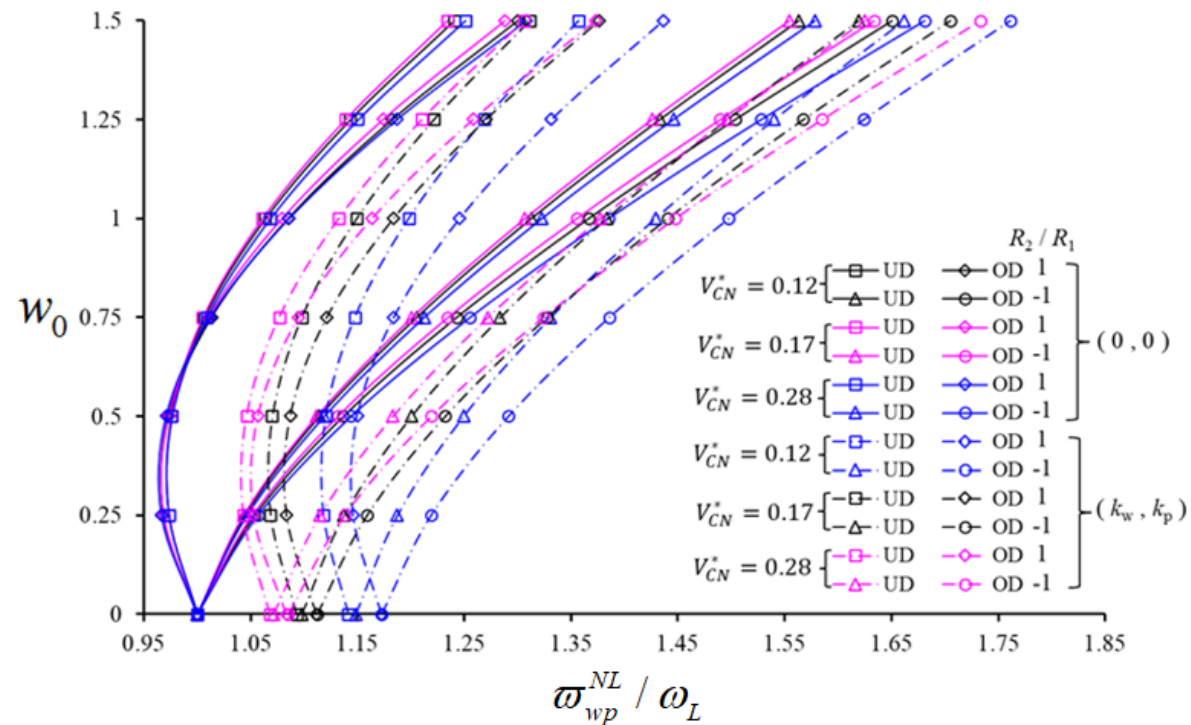
Figure 4. Variation in the NLFVF / LFVF ratio for shallow spherical and hypar shells with UD- and OD-patterned CNTs, in the presence/absence of a PF versus w 0 , with different V ∗